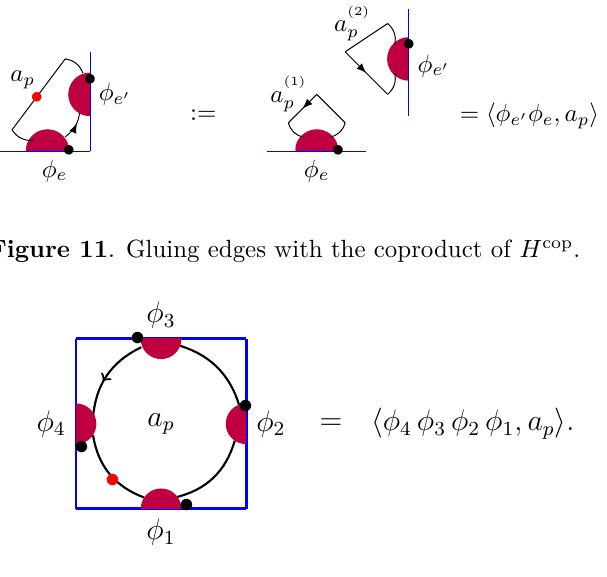
Figure 13 . For a given face bounded by at most to four edges, we determine the trace of the associated rank 2 tensor. The dashed line represents the possible other red disc contributions associated to the other edges bounding the face. The · · · in the formula encodes the elements φ i ∈ H ∗ associated to the edges bounding the face p . The red dot indicates that the edge we represented is the first in the (opposite)